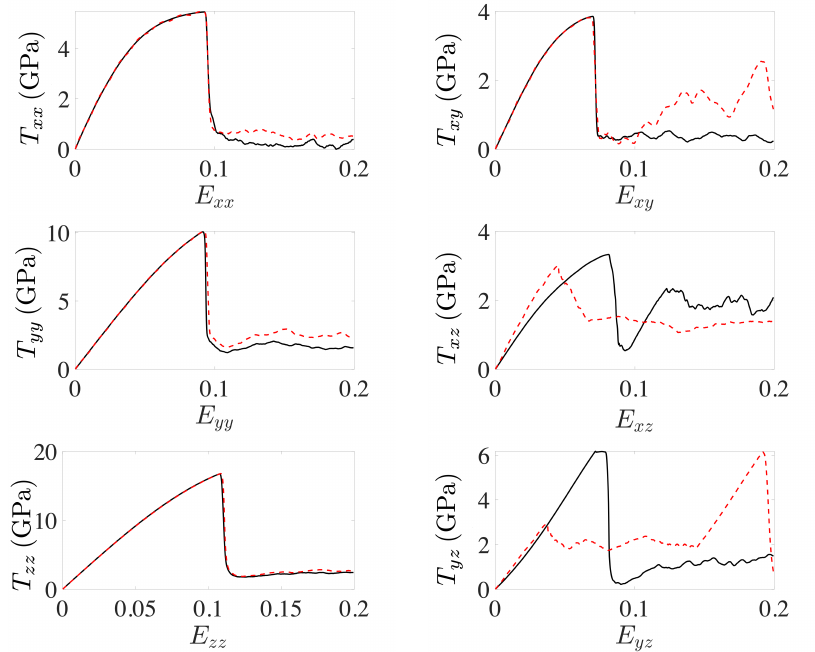
Figure 3. Stress-strain curves for untwinned (solid black line) and twinned fcc crystal (dashed red line) subject to loading with respect to a single stress component. All other components are